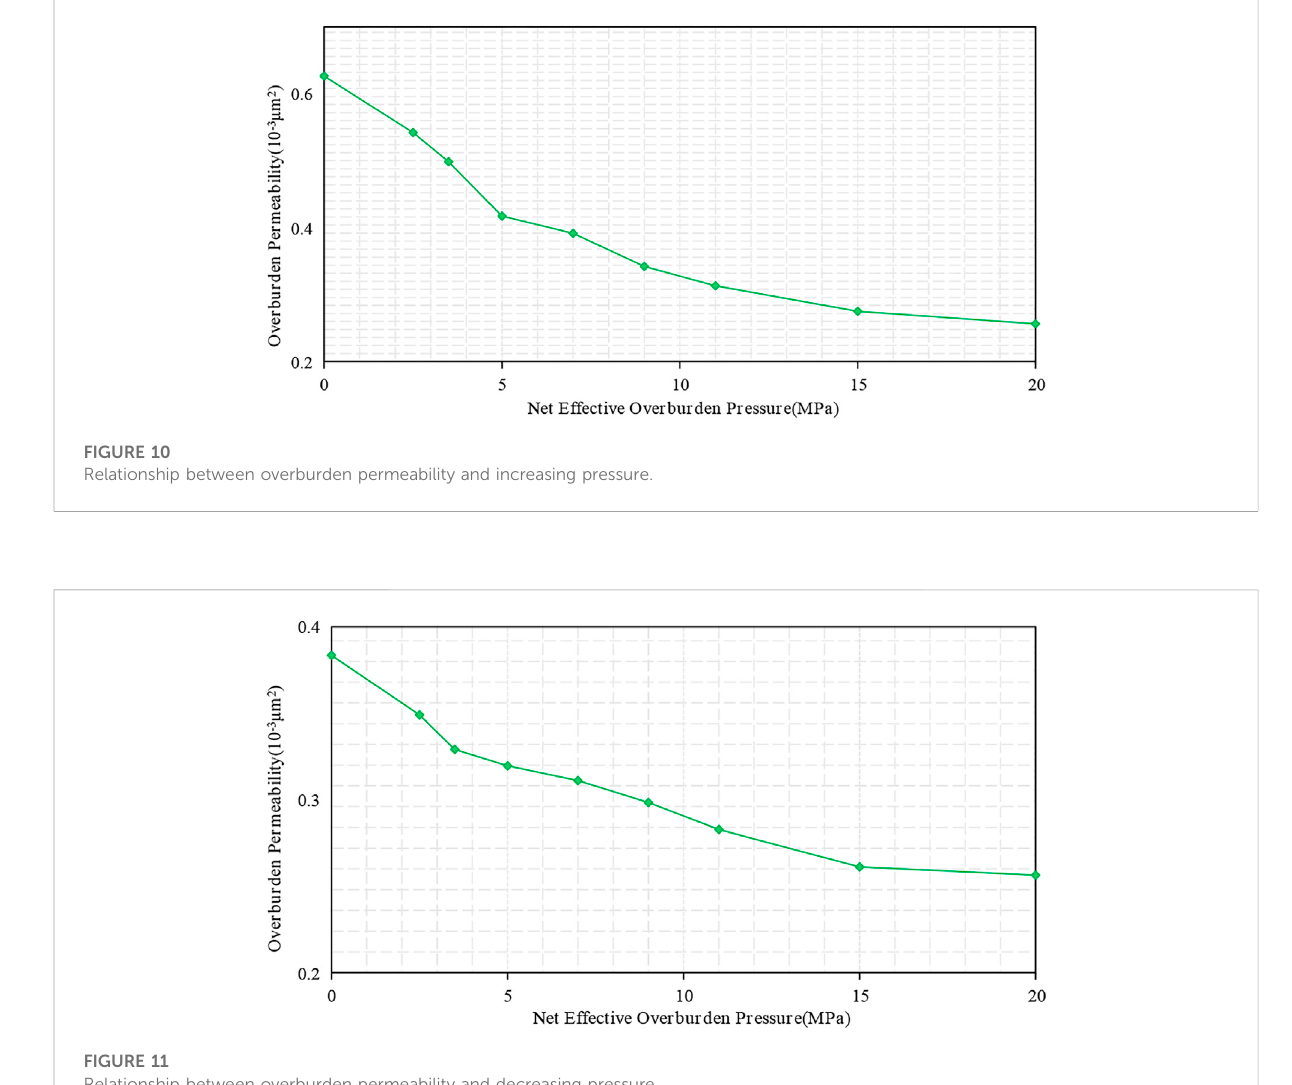
Relationship between overburden permeability and decreasing